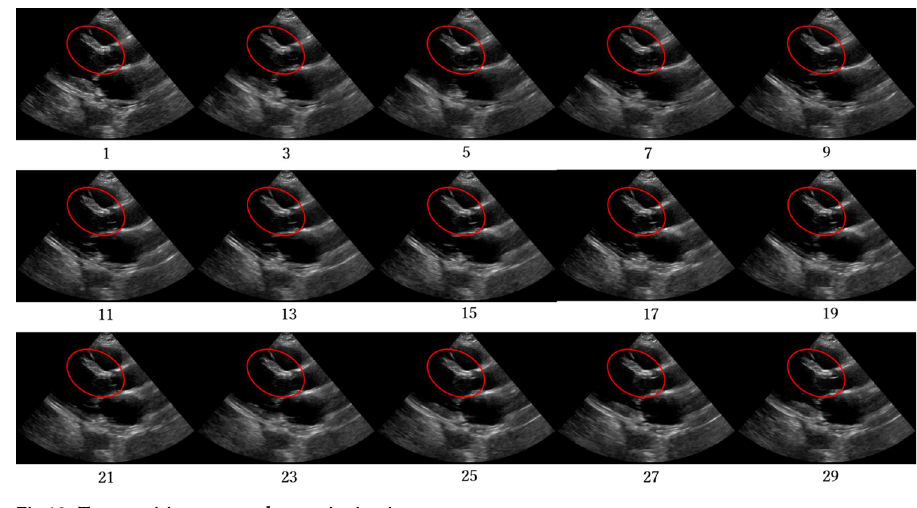
Fig 19. True-positive cases on long-axis view images.